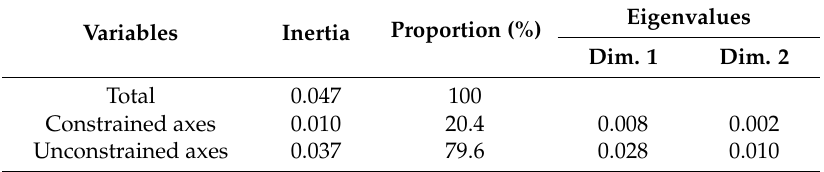
Table 4. Results of redundancy analyses applied to study the influence of normed mean water level, normed max water level, catchment area, population density and distance to the sea on river banks litter density.